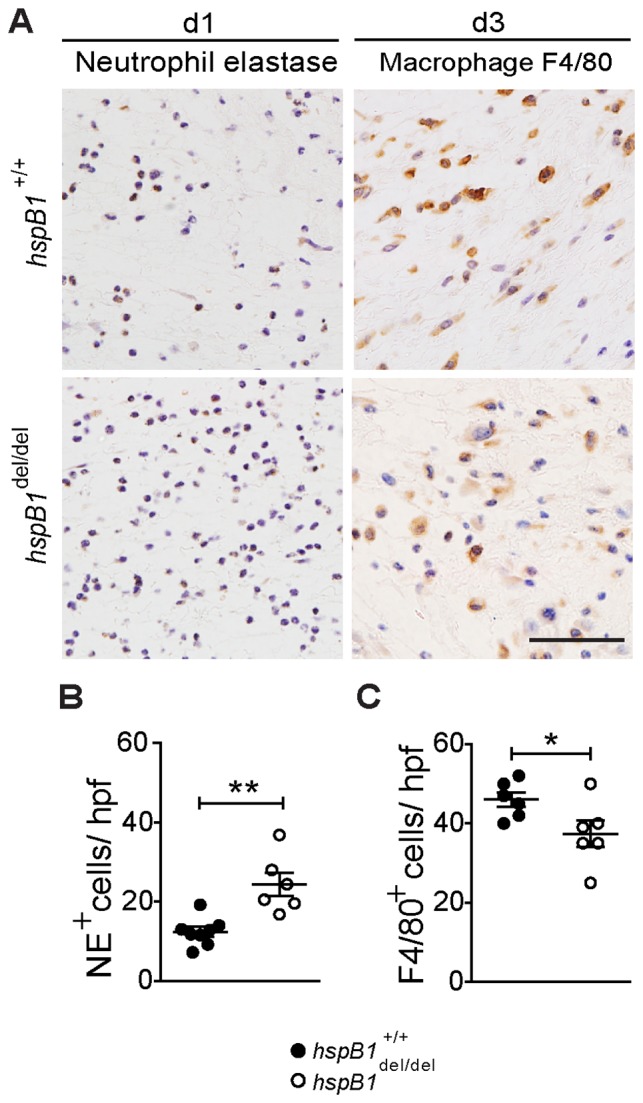
HspB1 deficiency results in increased neutrophil but slightly decreased macrophage infiltration of wounds.A, Neutrophil infiltration in d1 wound granulation tissue assessed by IHC for neutrophil elastase (NE) and macrophage infiltration at d3 detected by F4/80 staining. B, Plot shows elastase positive neutrophils (NE+) per high power field (hpf); 7 fields/wound; 2 wounds per mouse; n = 4 mice; **P<0.01. B, Plot as for (B) showing F4/80-positive cells/hpf; *P<0.05.